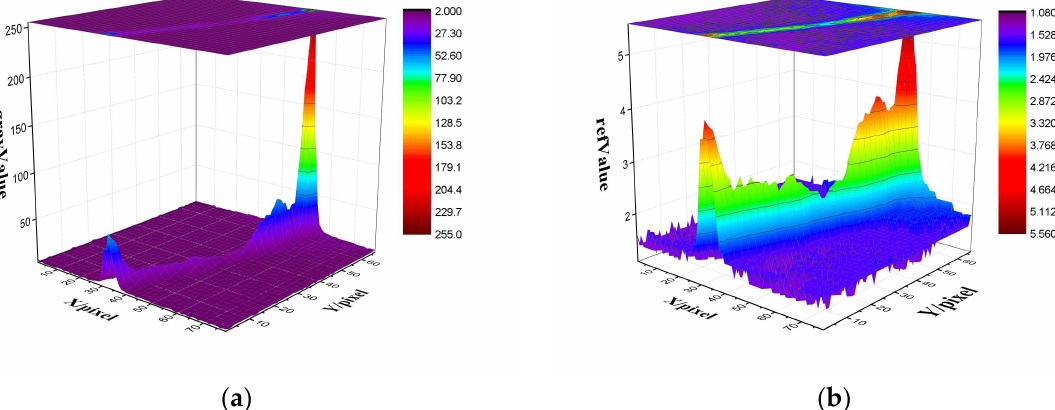
Figure 11. Stripe image gray and reflectivity distribution. ( a ) Gray distribution of the stripe image; ( b ) reflectivity distribution of the stripe image.